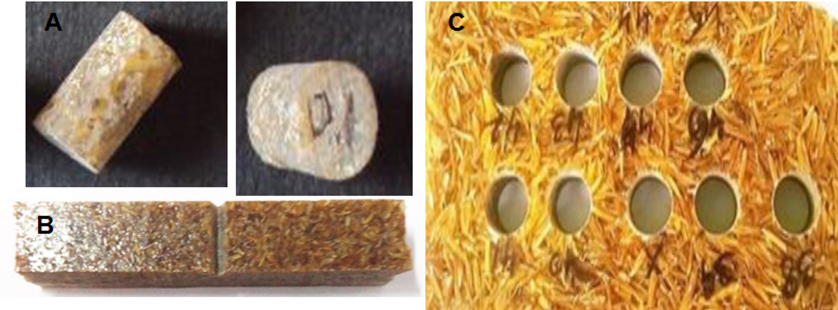
Figure 1: Laboratory made specimen for (A) compression test, (B) impact test and (C) drilled plate.